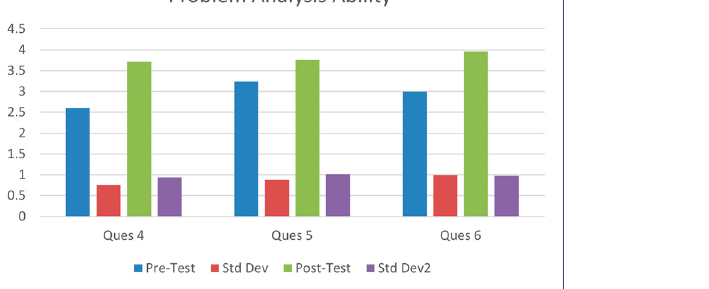
Figure 7. Students’ problem analysis ability in the previous test and the post-test.